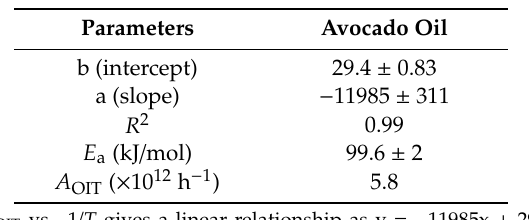
Table 2. Estimated Arrhenius parameters for avocado oil oxidation on isothermal conditions (ln k OIT vs. 1/ T ).